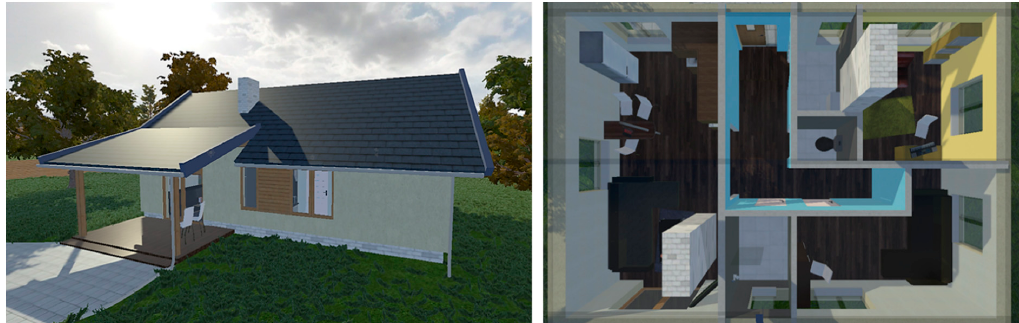
Figure 1. 3D BIM model for design review.